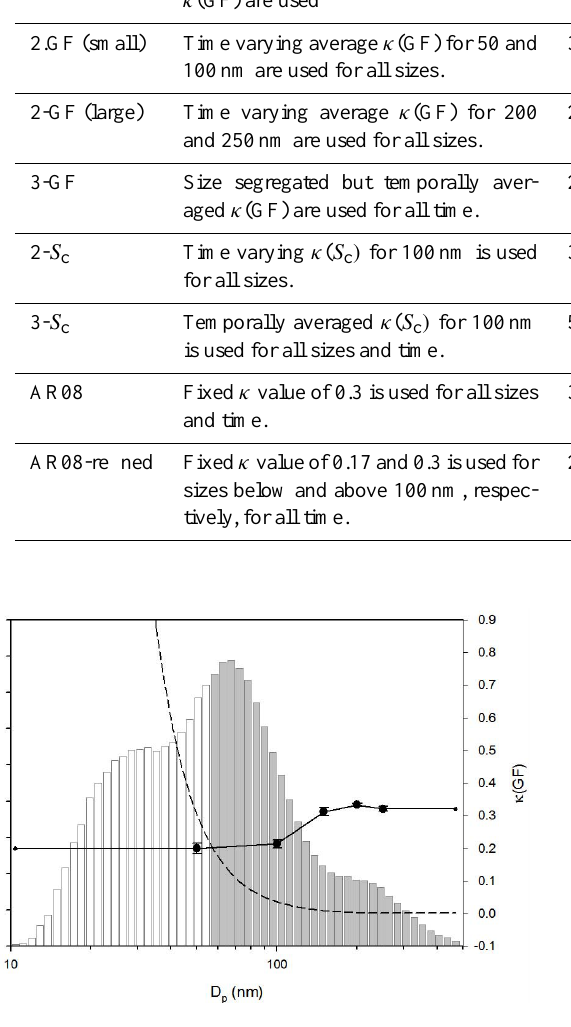
Fig. 10. An example of predicting N CCN at 0.6% S by combining measured κ (GF) (line with circle symbols) with the size distribu- tion. The dashed line denotes the minimum κ required for each size bin to be activated as CCN at 0.6% S . Only the grey vertical boxes are summed up to obtain the predicted N CCN based on the GF mea- surement. The error bars represent standard deviations of κ (GF).